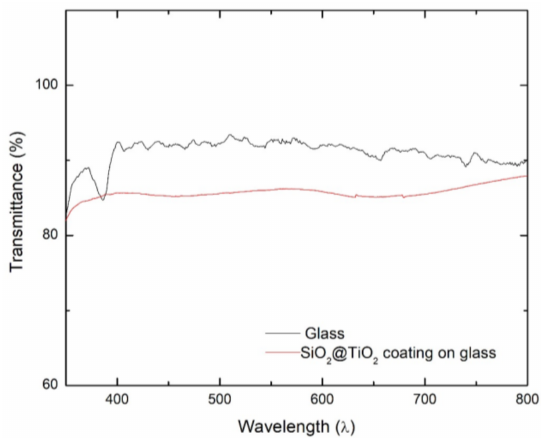
Figure 8. UV-Vis transmittance spectra of SiO 2 @TiO 2 coated on glass (red) and glass (black).